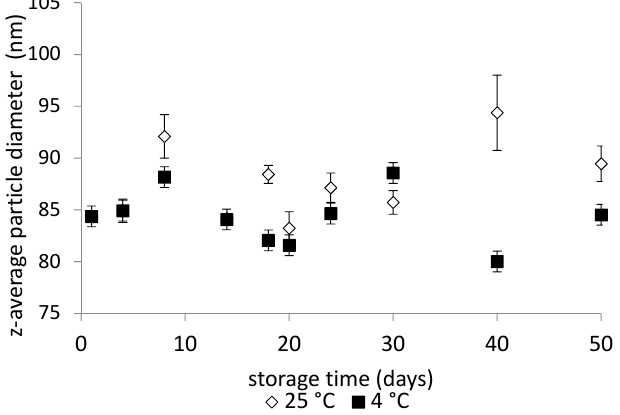
Figure 4. Changes in the z-average diameter of emulsion droplets as a function of storage time and temperature (4 and 25 °C) determined for emulsions with Tween 85/Span 85 (10 wt %) at HLB 9.